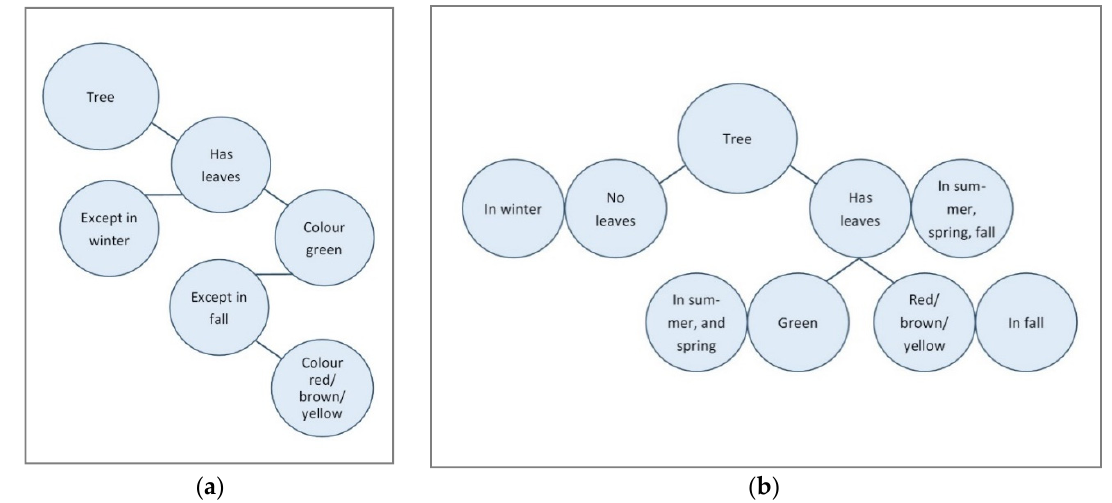
Figure 7. ( a ) Hypothetical knowledge structure A; ( b ) hypothetical knowledge structure B.